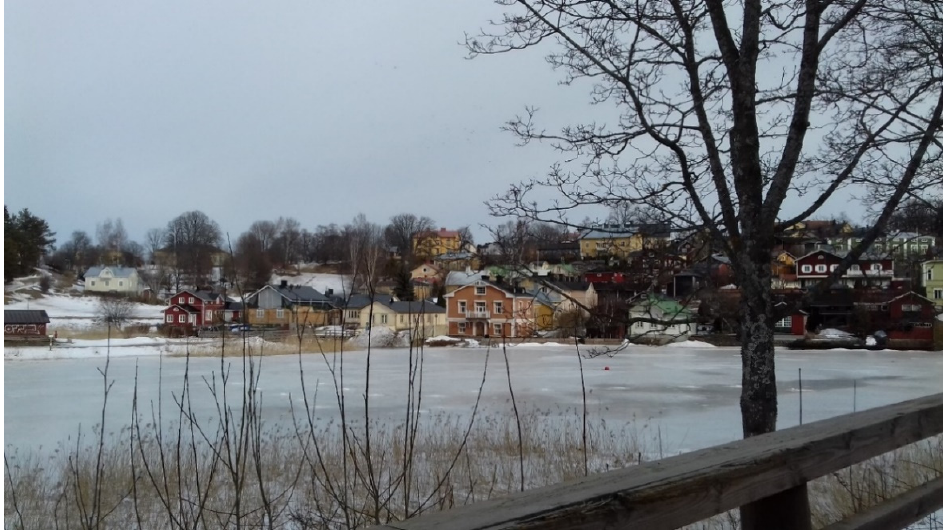
Figure 4. The Old Town part of the City of Porvoo is situated along the river and not far from the sea, where the risk of flooding is a current and relevant issue. Photograph by author Eeva Aarrevaara.